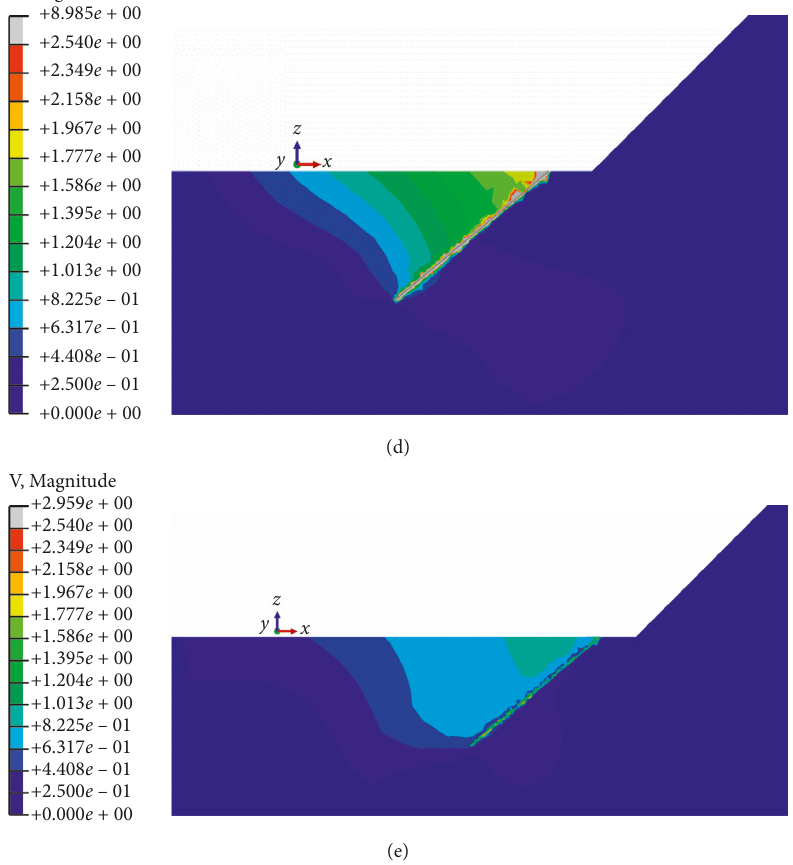
Figure 8: Time history contours of slope vibration velocity after blasting at (a) 1ms, (b) 1.5 ms, (c) 2ms, (d) 3ms, and (e) 7